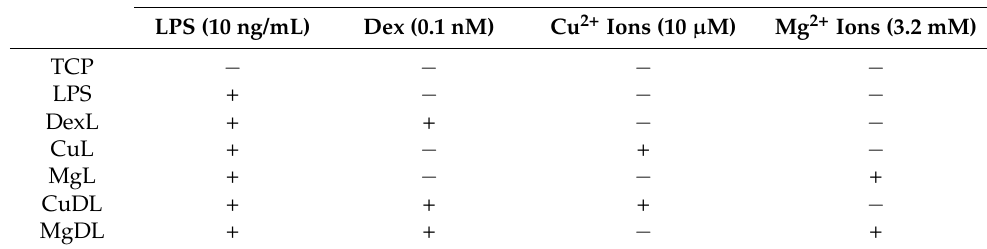
Table 2. Summary of the molecules incorporated into the cell culture medium in the different conditions that were